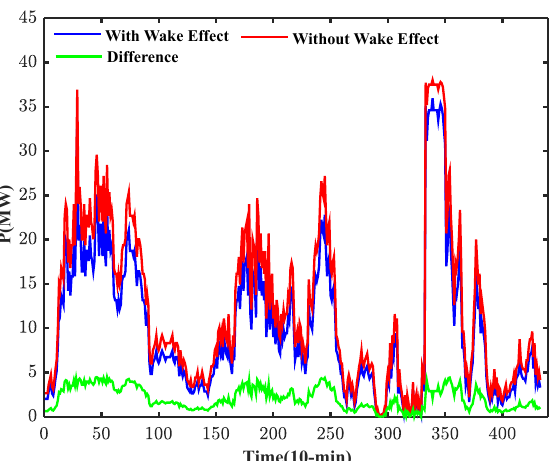
Figure 10. The wind farm’s output power for three